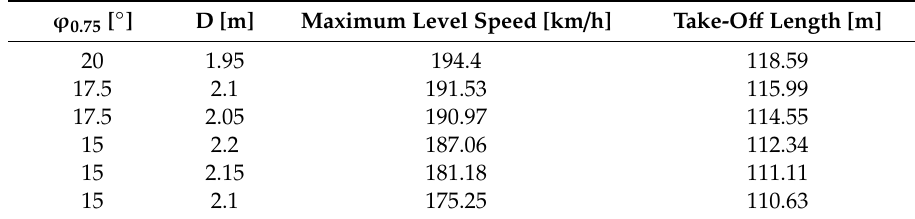
Figure 11. Pareto frontier for maximum horizontal flight speed (continuous engine regime) and maximum horizontal flight speed (cruise regime). Table 2. Points on the Pareto front for maximum horizontal speed (continuous engine regime) and take-o ff length (see Figure 7).